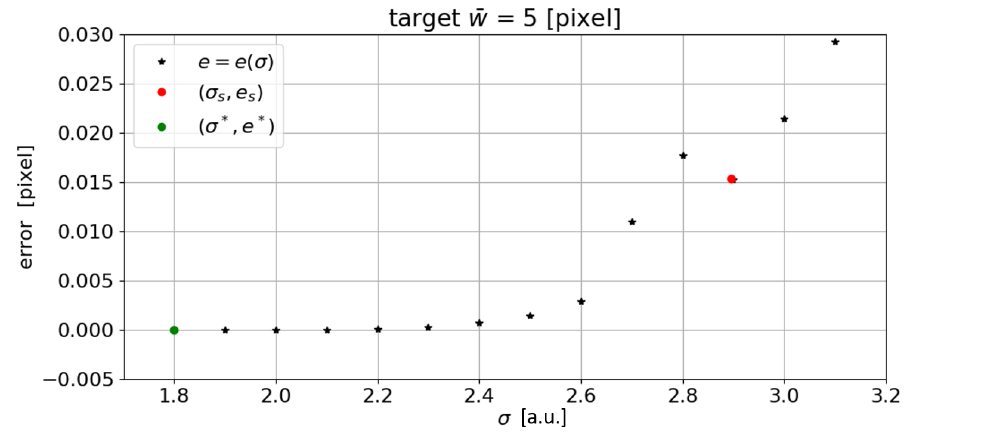
Figure 8. Detail of the graph in Figure 3, with the error shown in the abscissa. The minimum error is located at σ ∗ (a.u.: arbitrary